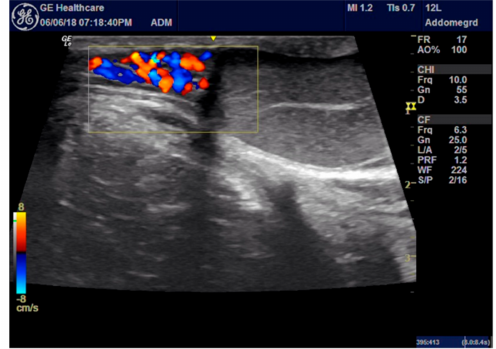
Figure 1. Ultrasound system images for procedural